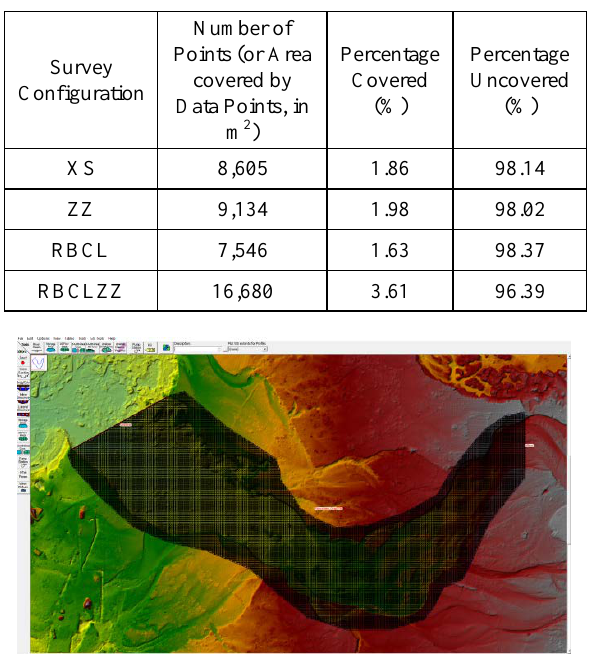
Table 1. Number of interpolation data points per survey configuration.